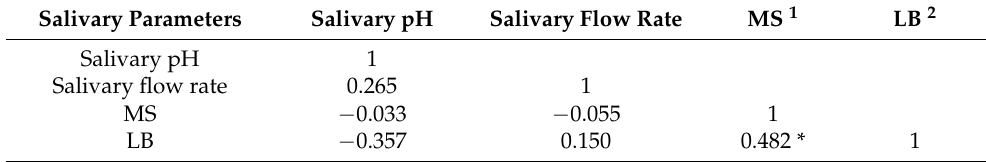
Table 3. Correlation coefficients of caries parameters in the high caries-affected group. Salivary